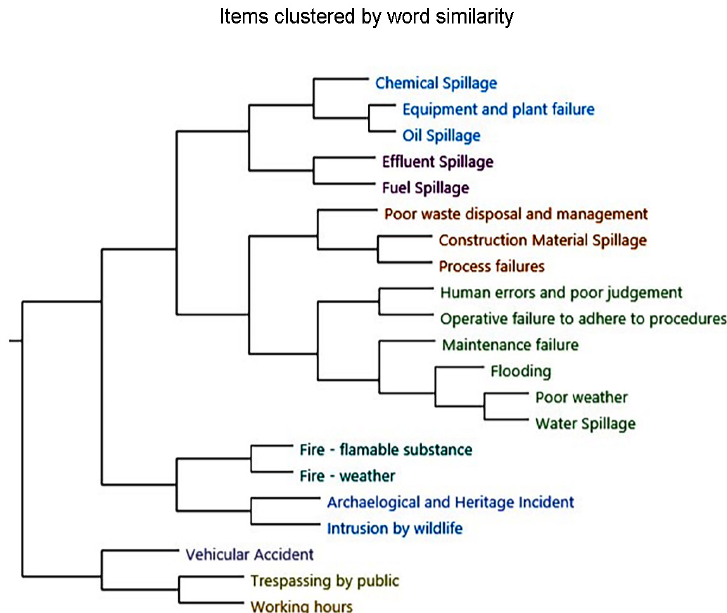
Figure 3. Causes of incidents nodes clustered by word similarity